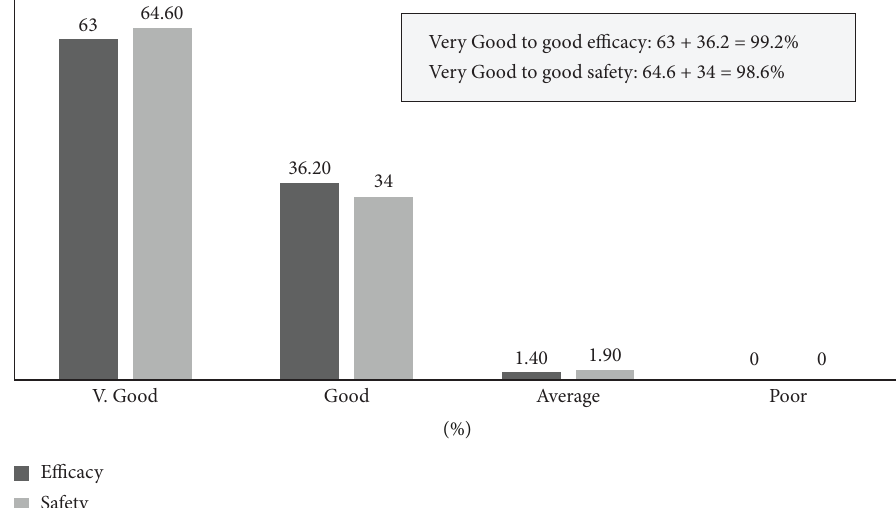
Figure 1: Physicians’ assessment on efcacy and safety of ferric carboxymaltose in pregnant